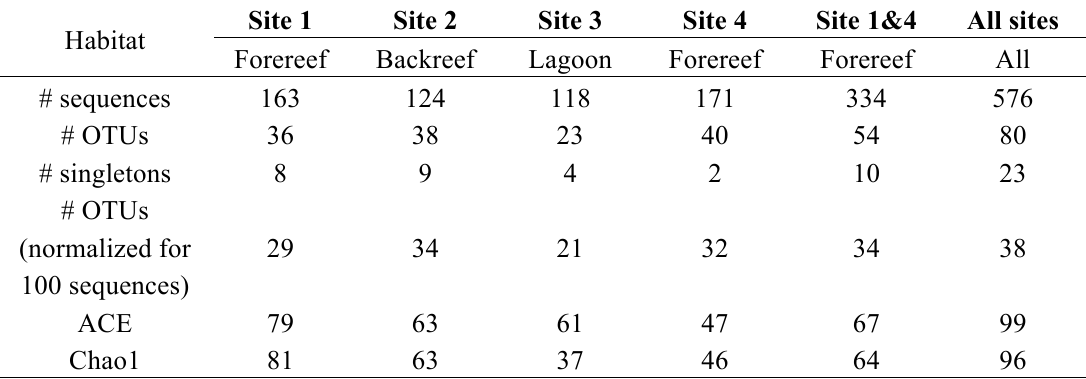
Table 2. Observed and estimated biodiversity at the four sampling